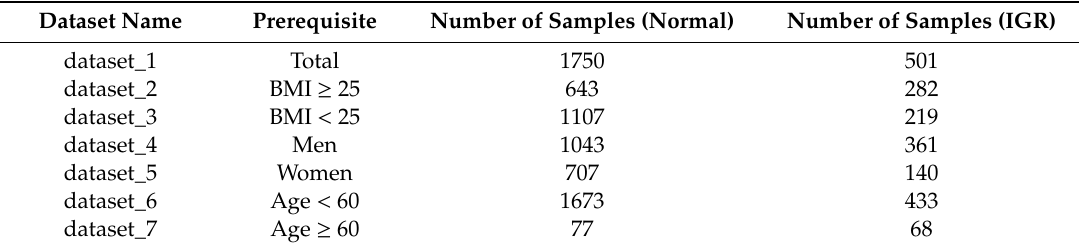
Table 1. The composition of the training sets in this paper.